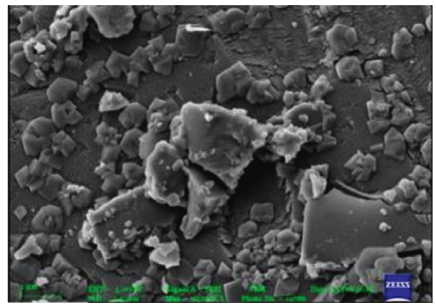
Figure 4: SEM image of